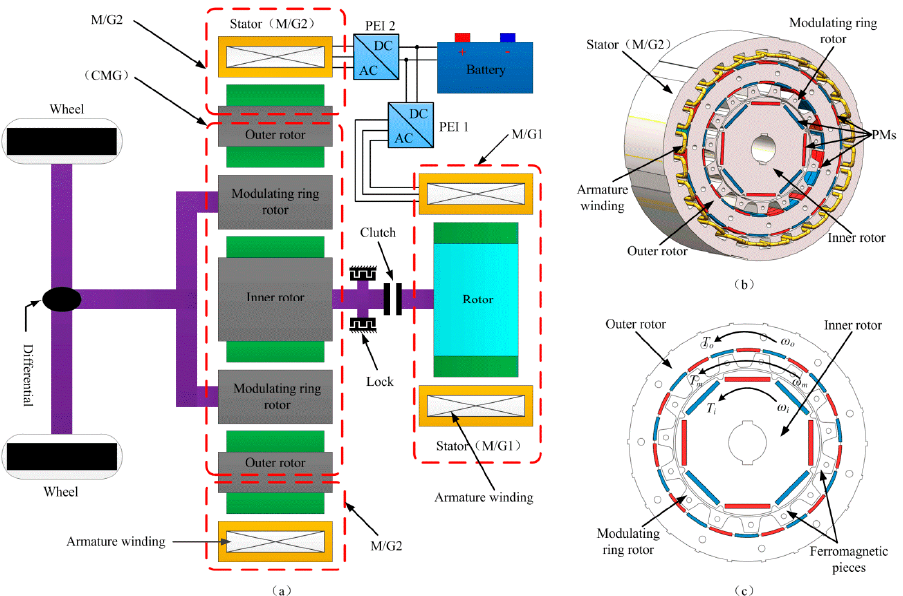
Figure 1. ( a ) Powertrain system configuration; ( b ) integrated magnetic gear permanent magnet (IMG-PM) machine; ( c ) coaxial magnetic gear (CMG).